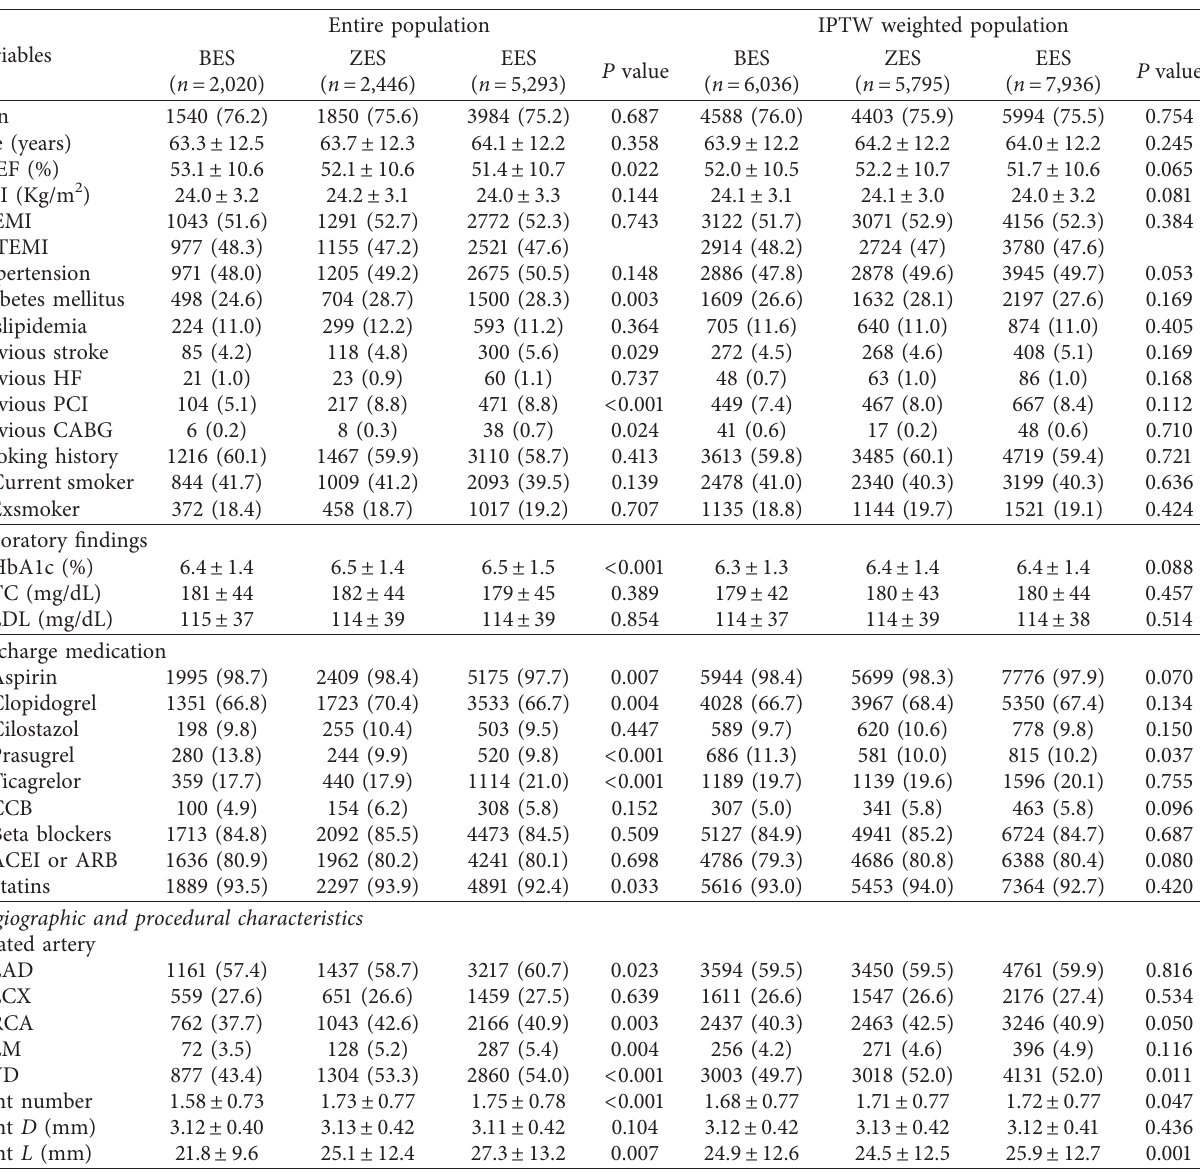
Table 1: Baseline clinical, angiographic, and procedural characteristics of acute myocardial infarction patients according to the use of DES